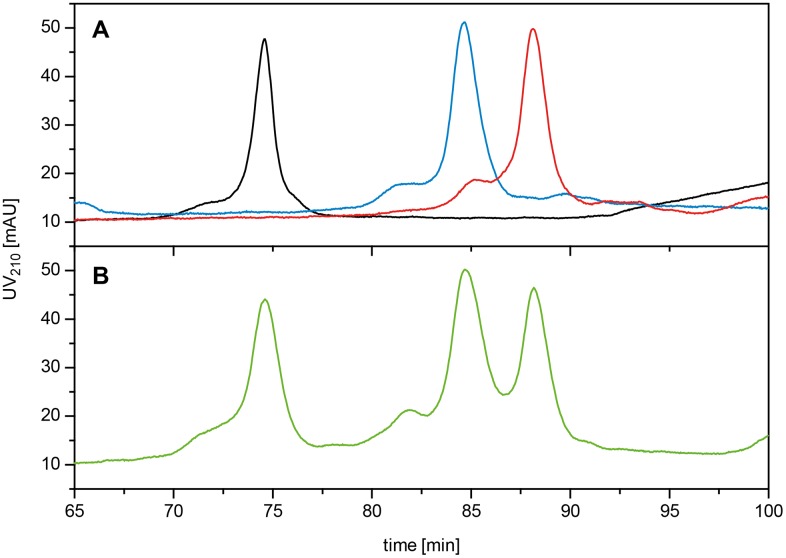
RP-HPLC analysis of individual and mixed PfAMA1-DiCo1, PfAMA1-DiCo2 and PfAMA1-DiCo3 samples.Upper panel: Injection of the individual PfAMA1 DiCo proteins to establish the chromatographic profile of each of these proteins. PfAMA1 DiCo1 in black, PfAMA1 DiCo2, in blue and PfAMA1 DiCo3 in red. Lower panel: Chromatogram of the drug product containing the three PfAMA1 DiCo proteins at equimolar ratios, in green. For chromatographic details see the Methods Section.